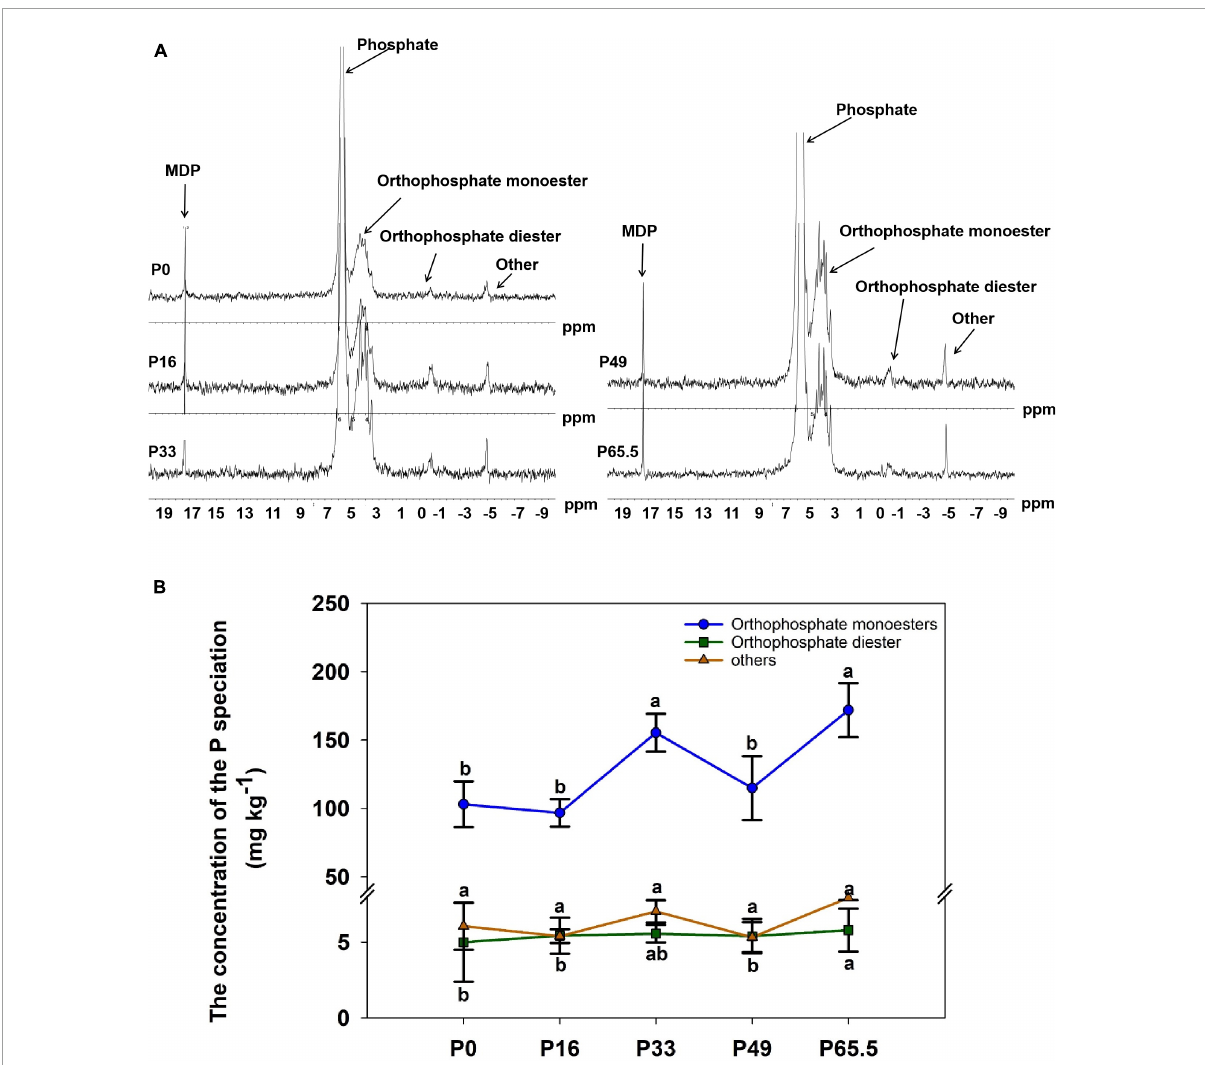
FIGURE1 The concentration of the P speciation under gradient P fertilization rates. (A) Solution 31 P NMR (nuclear magnetic resonance) spectra on NaOH-EDTA extracts for the five P fertilization rates. Nuclear magnetic resonance can be used to identify the exact molecular forms of P in soils. These include phosphate ( δ 5.83 ppm), orthophosphate monoester (OM) ( δ 4.75 ppm), orthophosphate diester (OD) ( δ –0.44 ppm), and others ( δ –4.76 ppm). (B) Line charts based on 31 P NMR. The data are based on the concentration of organophosphorus molecular form at five P fertilization rates. P0, P16, P33, P49, and P65.5 represent 0, 16, 33, 49, and 65.5 kg P ha − 1 applied,